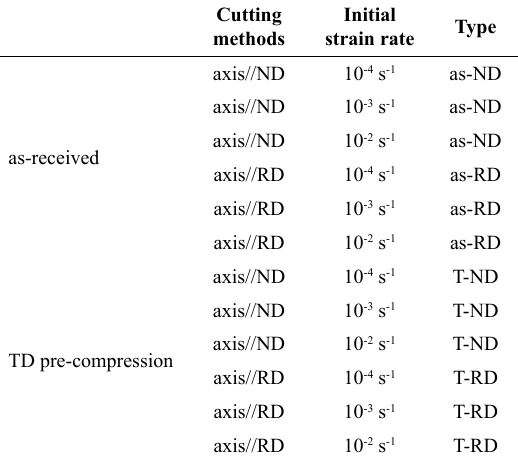
Figure 1. Schematic diagram of the compression specimens used in deformation tests. Table 2. Compression test conditions for AZ31